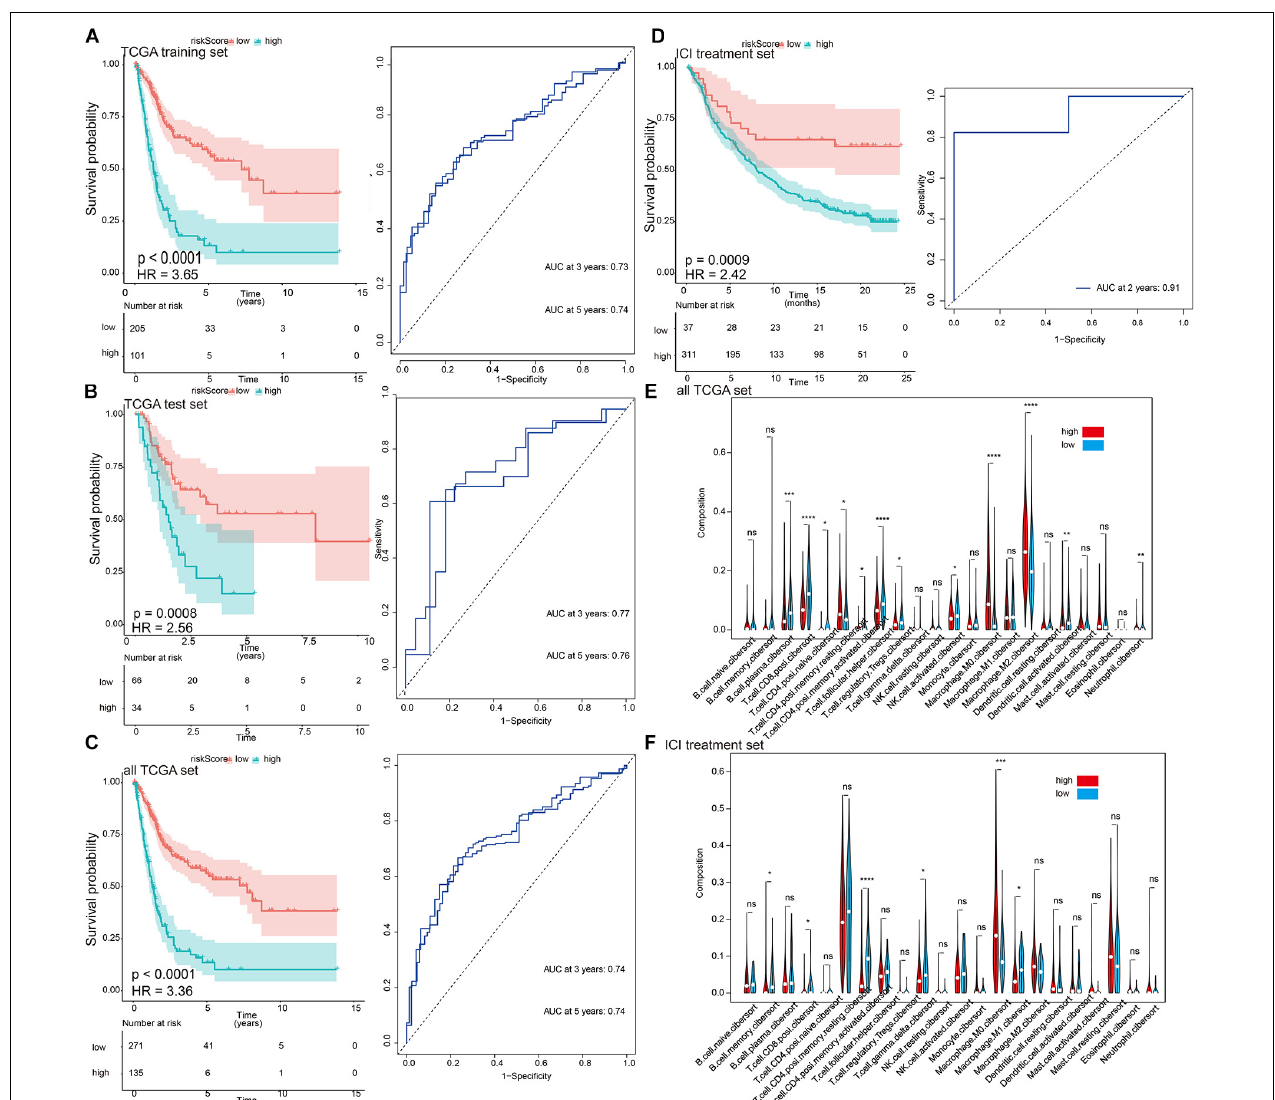
FIGURE 3 | The characterization of the training and validation cohorts highlights that risk scores are potential biomarkers. (A–D) Kaplan–Meier survival analysis and time-dependent receiver operating characteristic (ROC) curve of the risk signature. The risk score derived from the constructed model is significantly correlated with overall survival. (E,F) The infiltration trends of 22 immune cells are consistent in the two data sets. * p < 0.05, ** p < 0.01, *** p < 0.001, **** p < 0.0001.